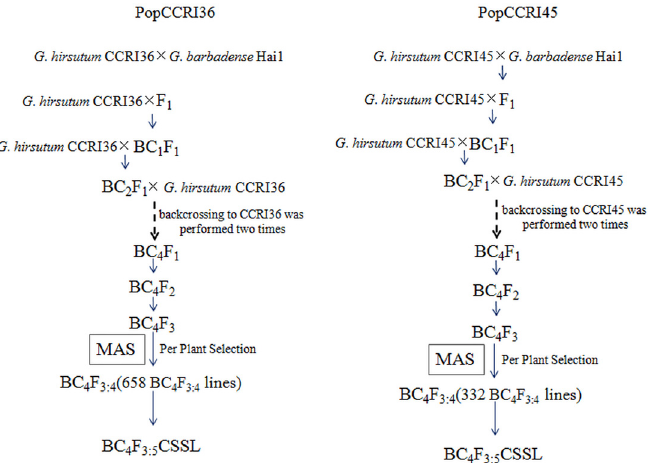
Fig 1. Breeding scheme for the development of the chromosome segment substitution lines